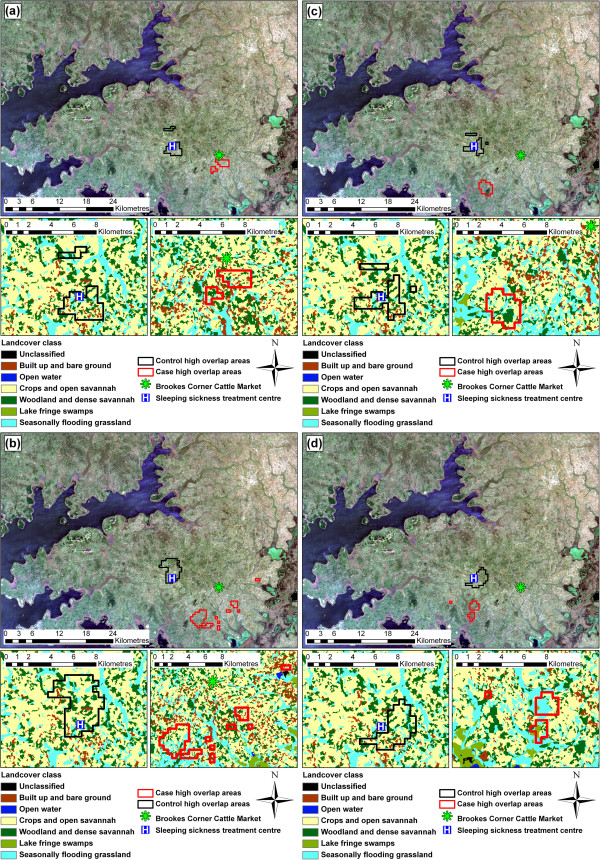
Case and control high overlap areas. True colour Landsat ETM+ composite of study area highlighting case (red) and control (black) high overlap areas in the first (a), second (b), third (c) and fourth (d) annual periods, also with close up images of high overlap areas with land cover classes.